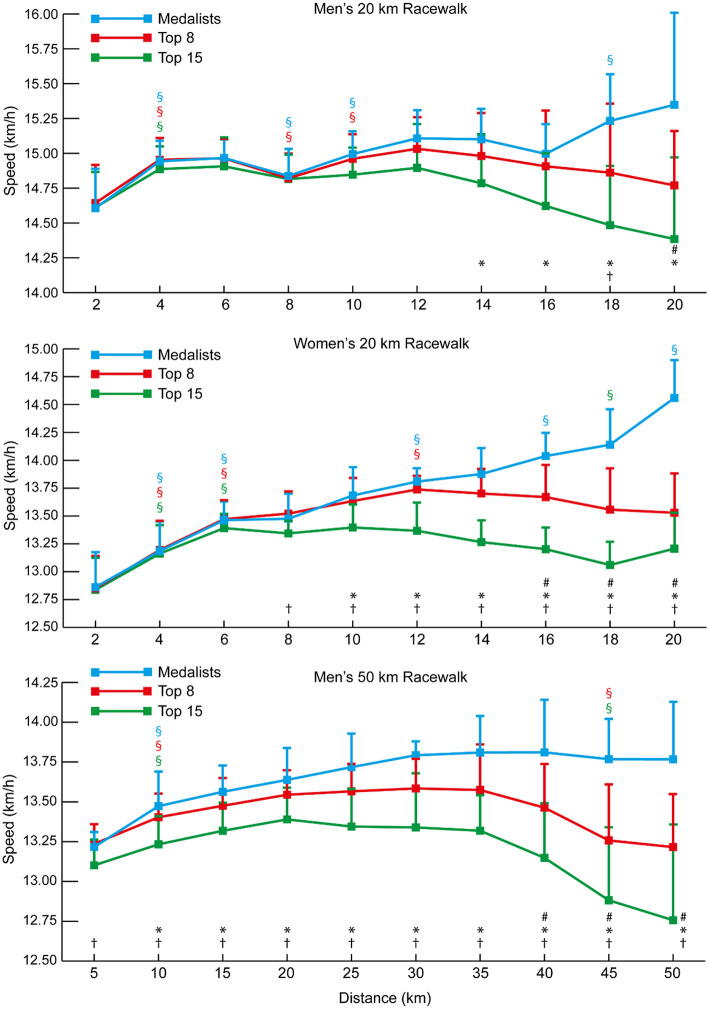
The mean (+ SD) 2-km segment speed (20 km event) and 5-km segment speed (50 km event) for each group of men and women racewalkers. Differences between successive segments (p < 0.05, d ≥ 0.61) are represented by § (blue for medalists, red for Top 8, and green for Top 15). Differences in segment speed between groups (p < 0.05, d ≥ 0.61) have been annotated for medalists vs. Top 8 (#), medalists vs. Top 15 (*), and Top 8 vs. Top 15 (†).